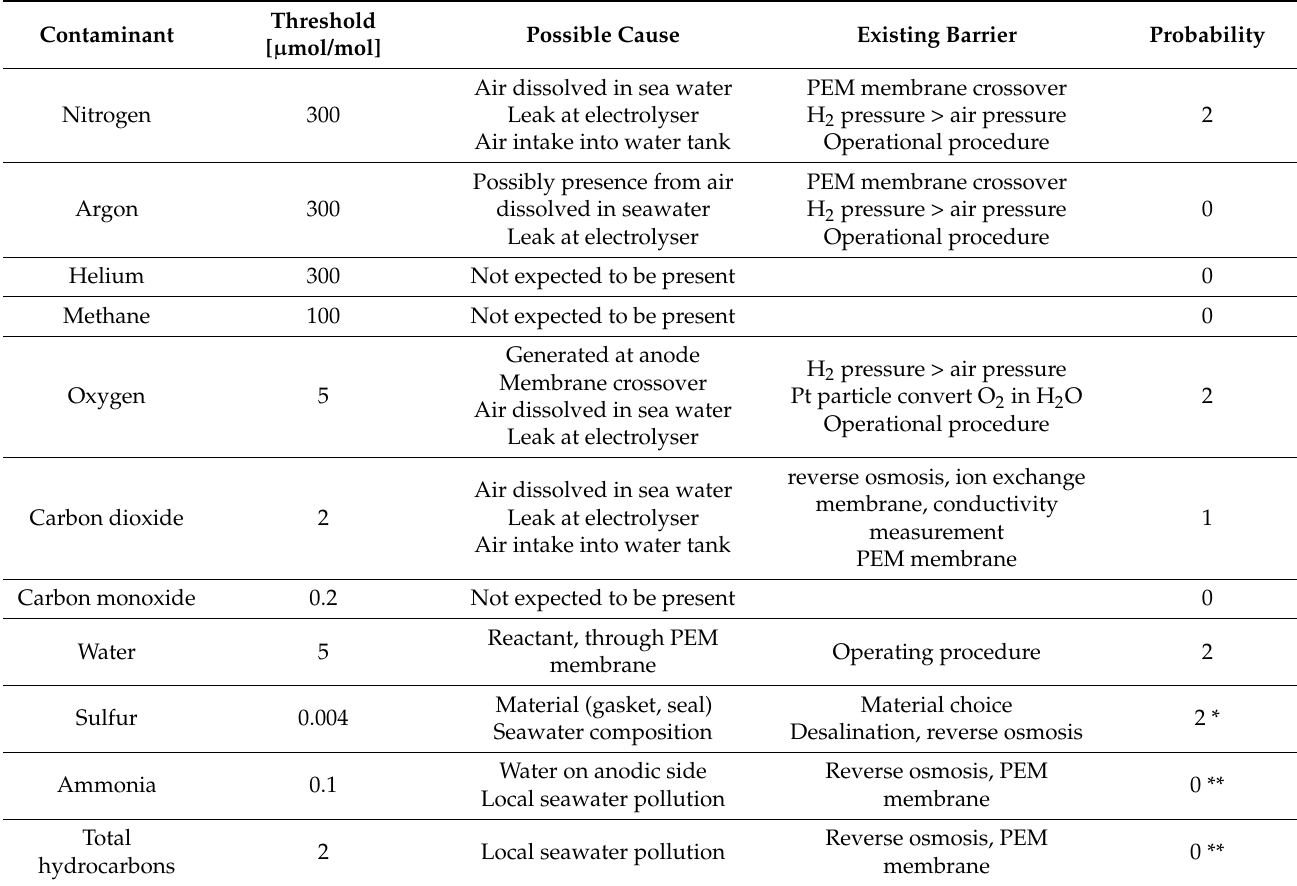
Table 2. Probability of occurrence of ISO 14687 contaminants in hydrogen produced from onboard electrolyser using purified seawater. Some probabilities proposed may be changed based on technical evidence. Existing Barrier